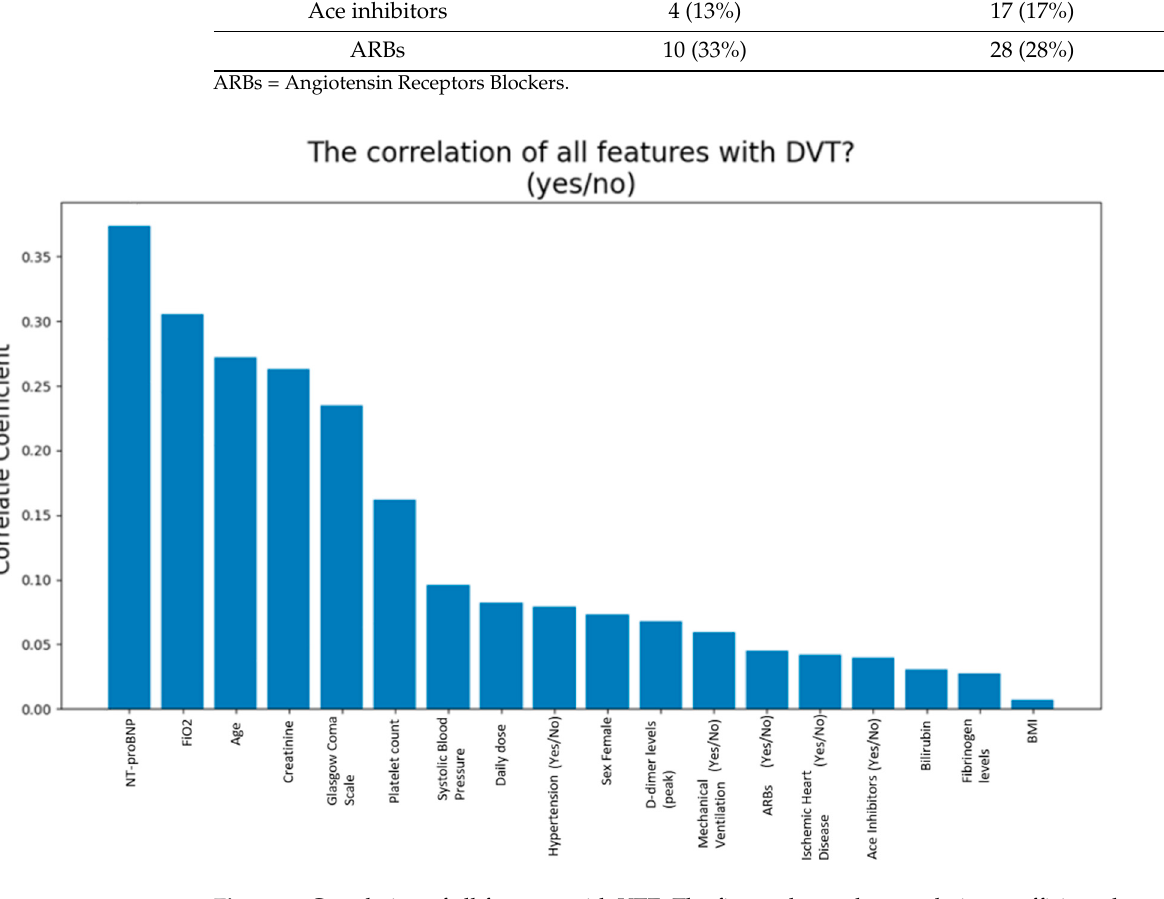
Figure 3. Correlation of all features with VTE. The figure shows the correlation coefficients between all characteristics ( n = 18) and the VTE characteristic. NTpro-BNP is the variable with the higher degree of correlation with